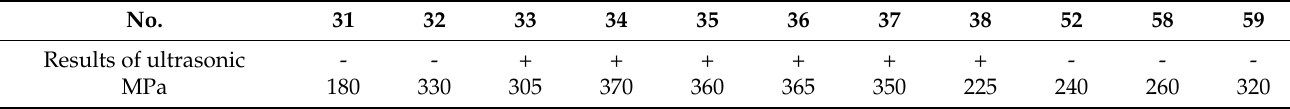
Table 11. Results of ultrasonic testing of the connection 12KH18N10T+M1+NbStrip-1+VT-14.